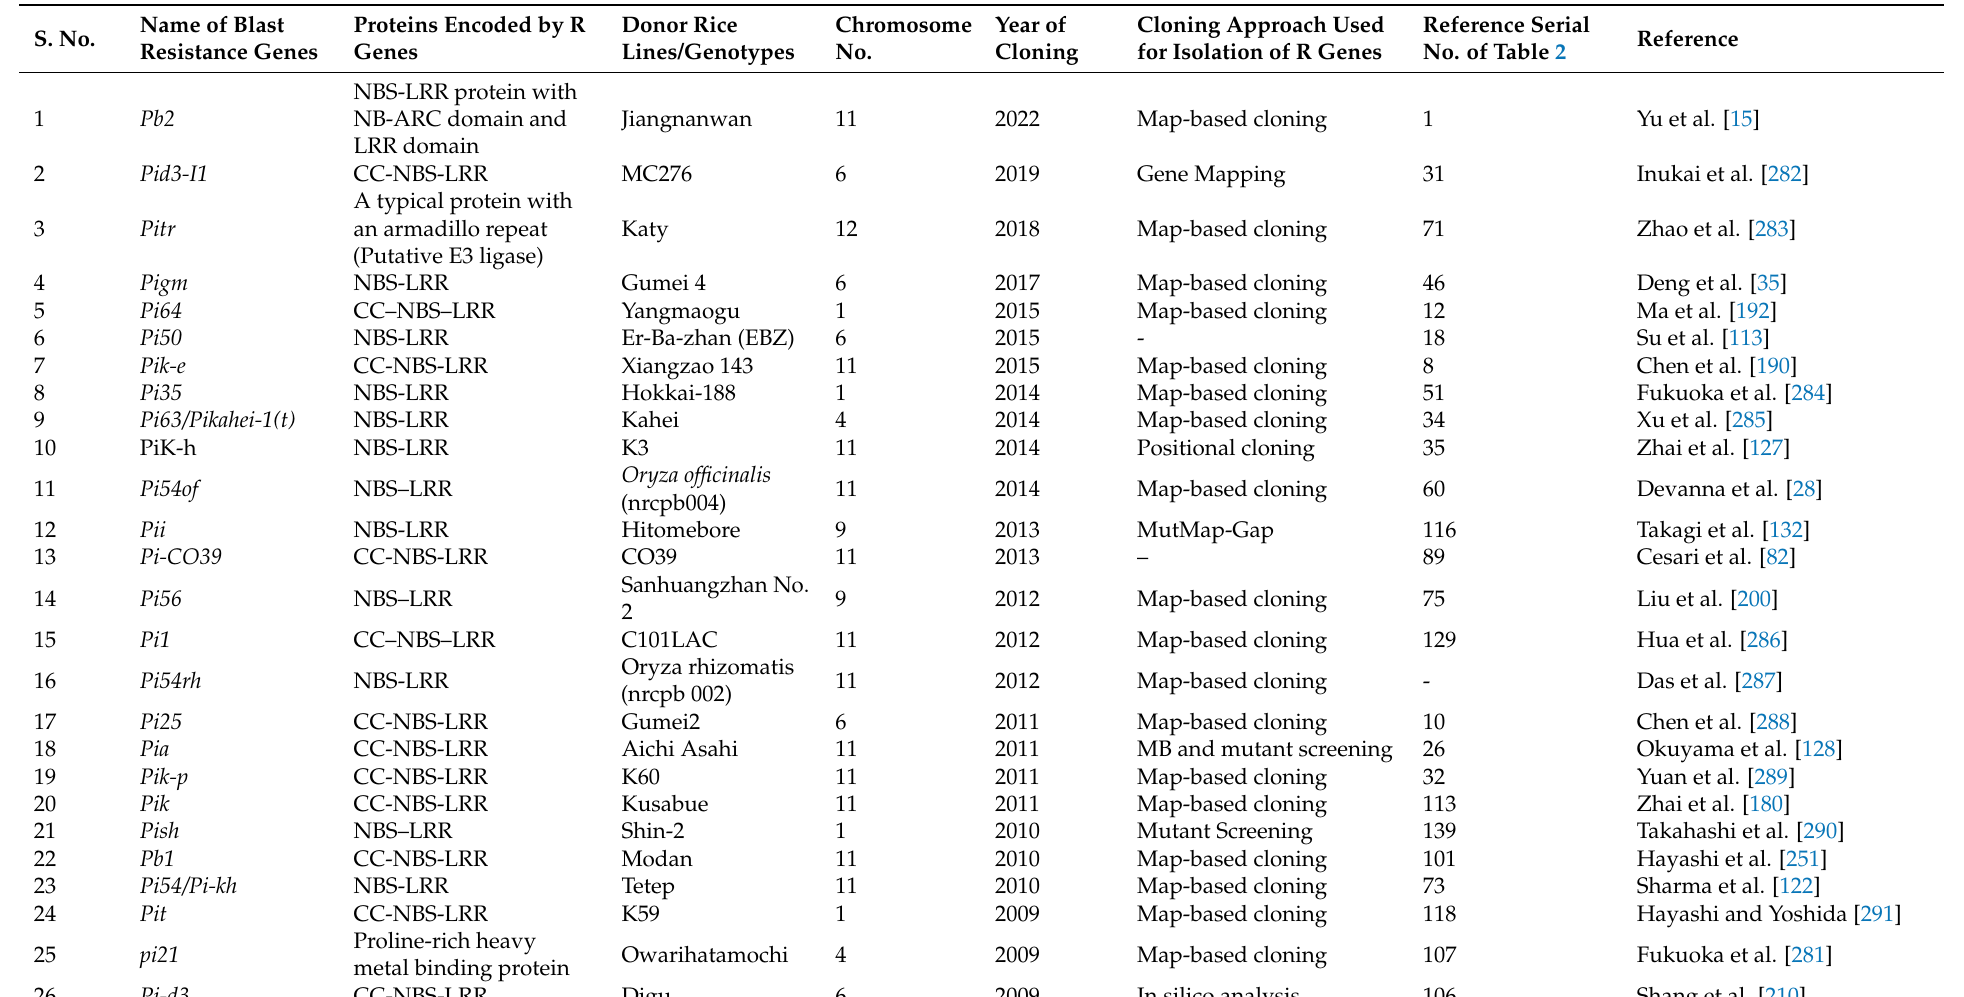
Table 3. List of blast resistance genes cloned, cloning strategy and their location on rice